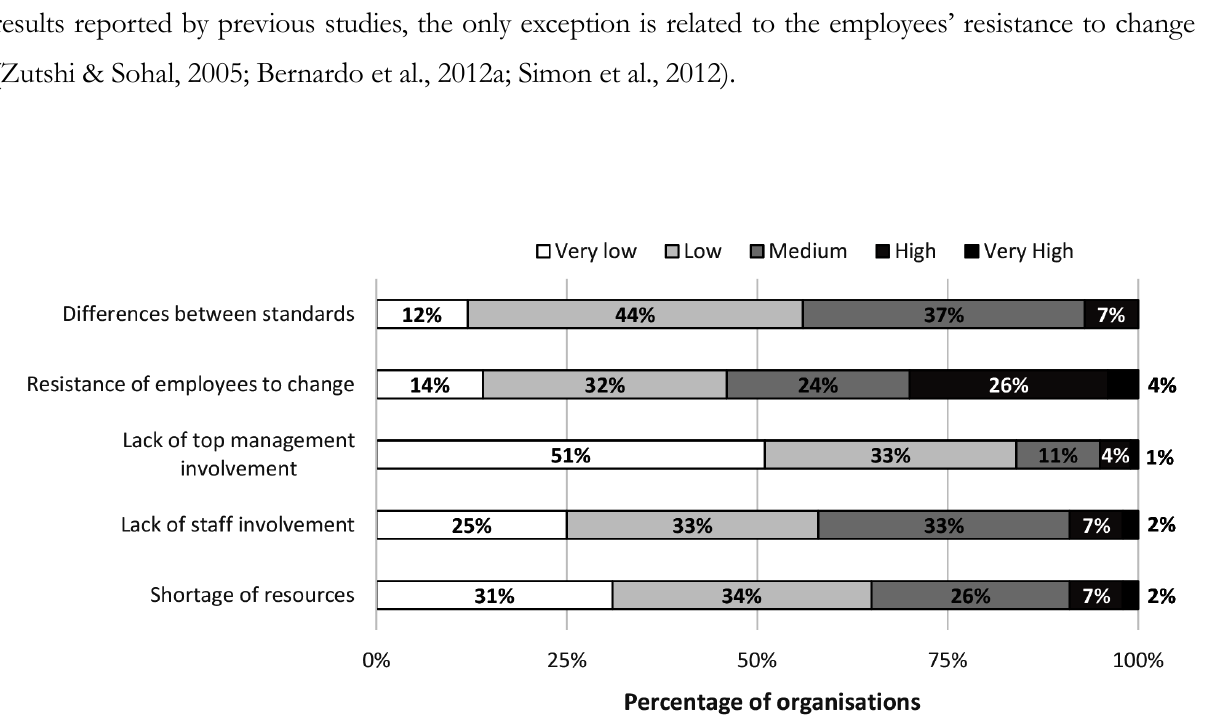
Figure 1. Degree of perceived difficulties during the integration of management